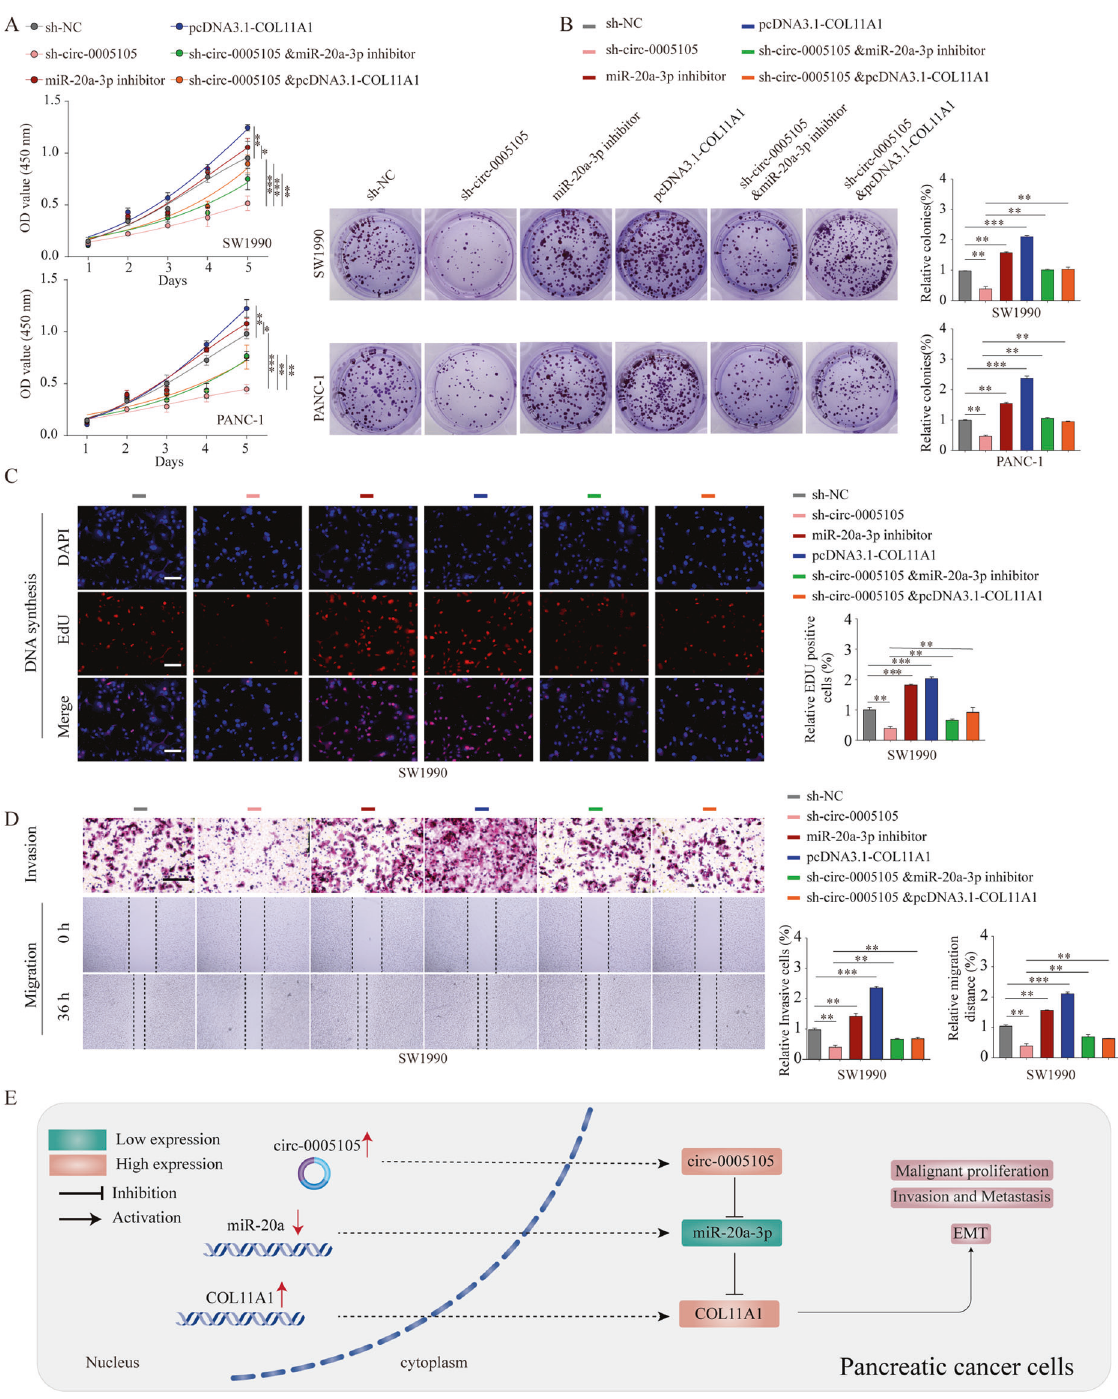
Fig. 8 The oncogenic circ-0005105/ miR-20a-3p/COL11A1 axis in pancreatic cancer cells. A The CCK-8 assays, and colony formation assays ( B ), EdU assays ( C ), and transwell assay ( D ) were used to evaluate the cell growth or invasiveness after transfection with sh-NC, sh-circ-0005105, miR-20a-3p inhibitor, pcDNA3.1-COL11A1, or co-transfected with sh-circ-0005105 and miR-20a-3p inhibitor or pcDNA3.1-COL11A1 in pancreatic cancer cells. A mechanism diagram depicting that the circ-0005105/ miR-20a-3p/COL11A1 axis affects the progression of pancreatic cancer through activating EMT. The results are presented as the mean ± SD for each group. * P < 0.05, ** P < 0.01, *** P < 0.001.